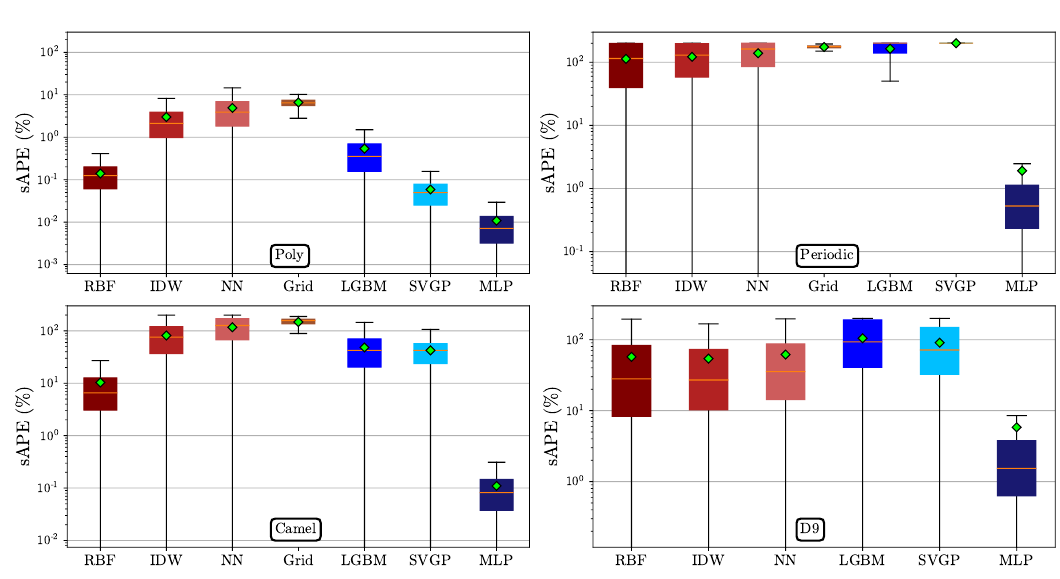
Figure 11: Boxplots of the symmetric absolute percent error (%) for four test func- tions in 9 dimensions. Red colors indicate interpolation while blue colors indicate regression methods.